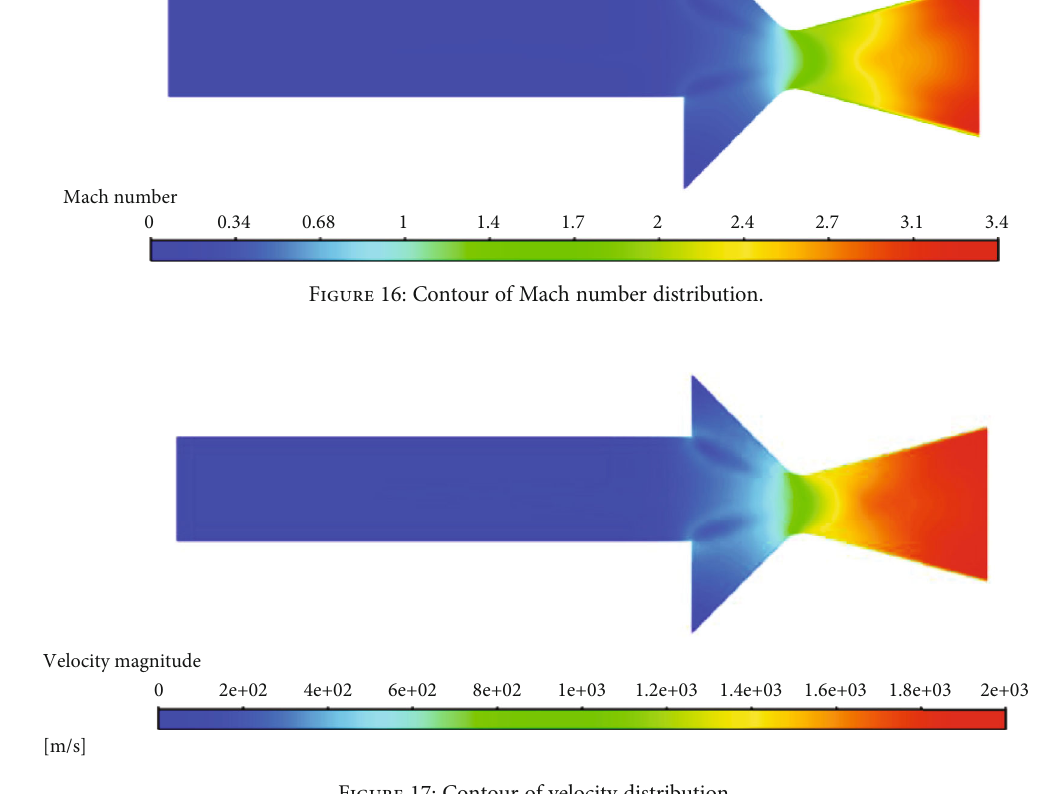
Figure 17: Contour of velocity